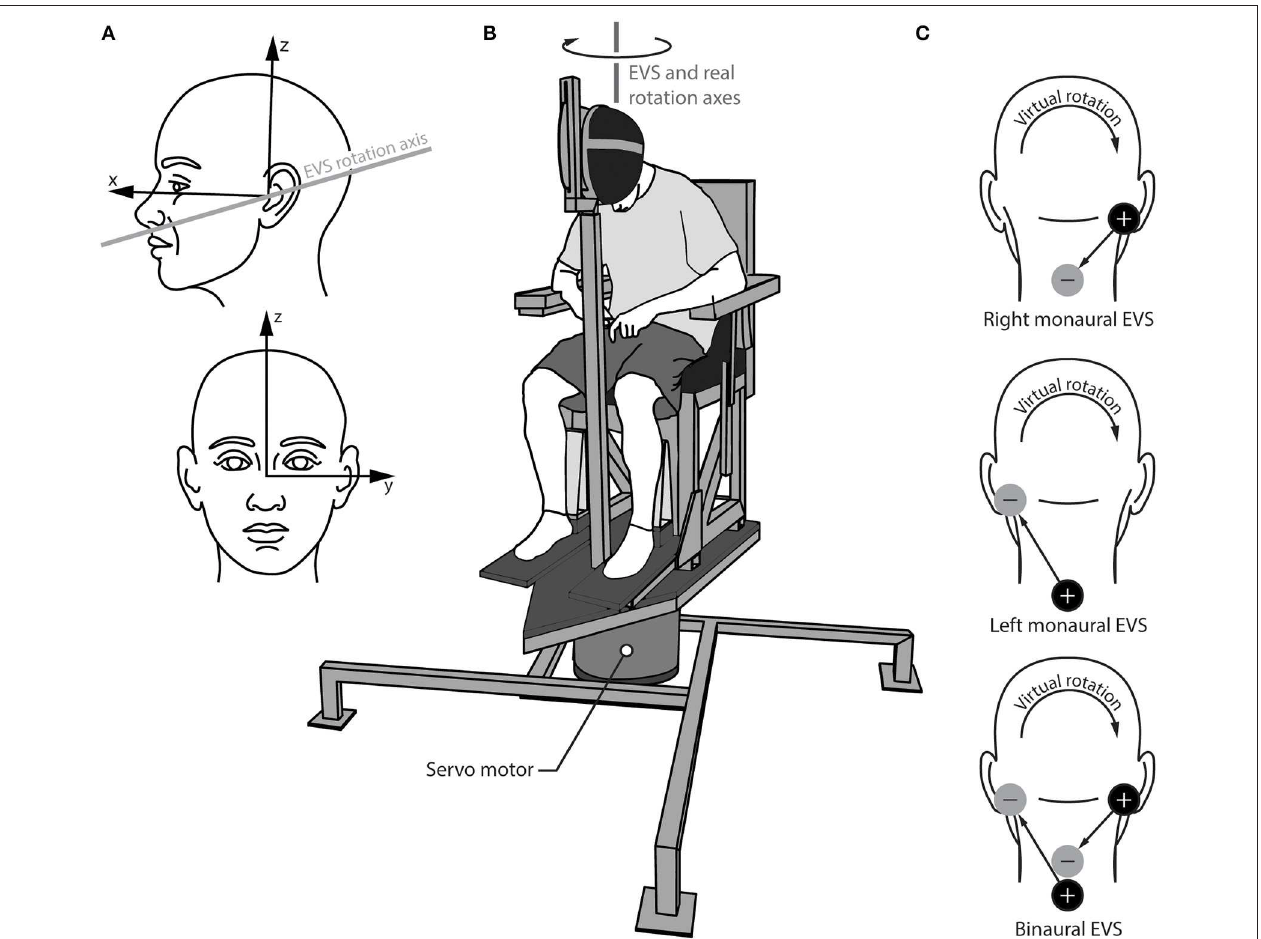
FIGURE 1 | Experimental set up the for real and virtual rotations. (A) Head reference frame showing the orientation of the virtual axis of rotation for electrical vestibular stimulation (EVS); (B) rotary chair and helmet set up showing the virtual EVS rotation axis and the real rotation axis aligned vertically in the lab frame; (C) electrode configurations for the right and left monaural stimulations (top two schematics) and the binaural stimulation (bottom schematic). The cathode ( + ) and anode (–) locations depict the configuration for the positive waveform, which induces the virtual rotation directions shown. The arrows from the cathode to the anode show the direction of the positive